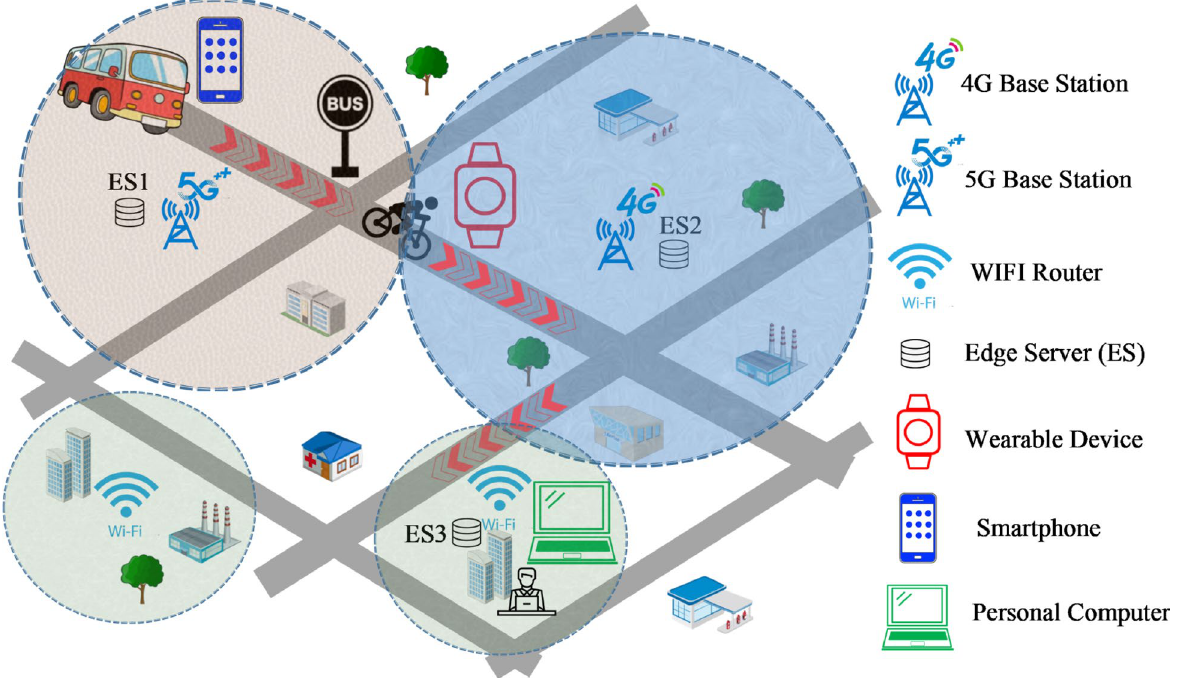
Fig. 1 Motivation scenario in intelligent edge computing